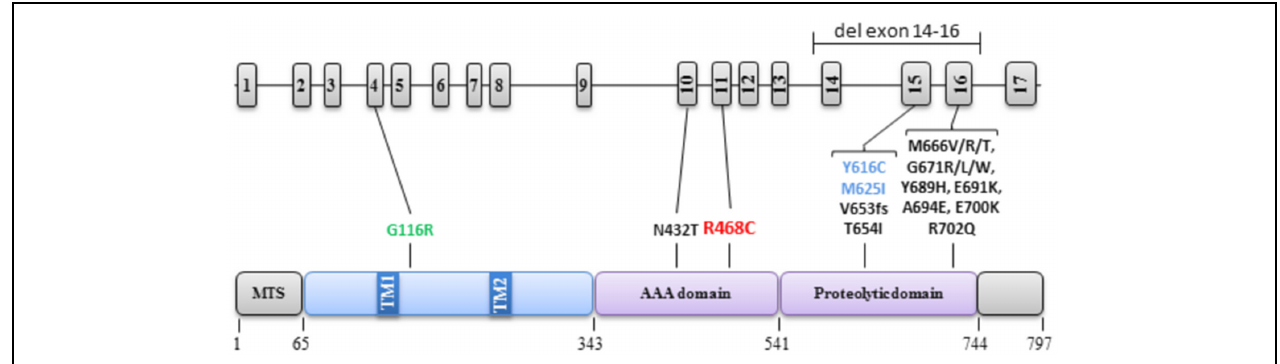
FIGURE 4 | Localization of AFG3L2 mutations in the gene and protein. The structures of AFG3L2 gene (17 exons) and the protein (domains and amino-acid positions) are described on the top and bottom of the figure, respectively, with all the pathogenic mutations and associated clinical presentation reported to date. In black: SCA28, in blue: SPAX5, in green: Myoclony and pyramidal signs, in red: present case.